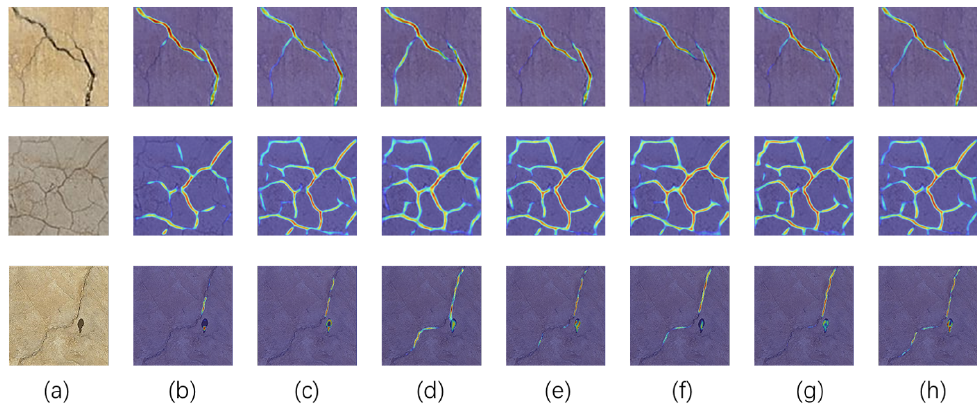
Figure 11. ( a ) Raw, ( b ) U-net, ( c ) U-Net+CCT, ( d ) U-Net+BiFPN, ( e ) U-Net+FCA, ( f ) U-Net+CCT +BiFPN, ( g ) U-Net+CCT+FCA, ( h )